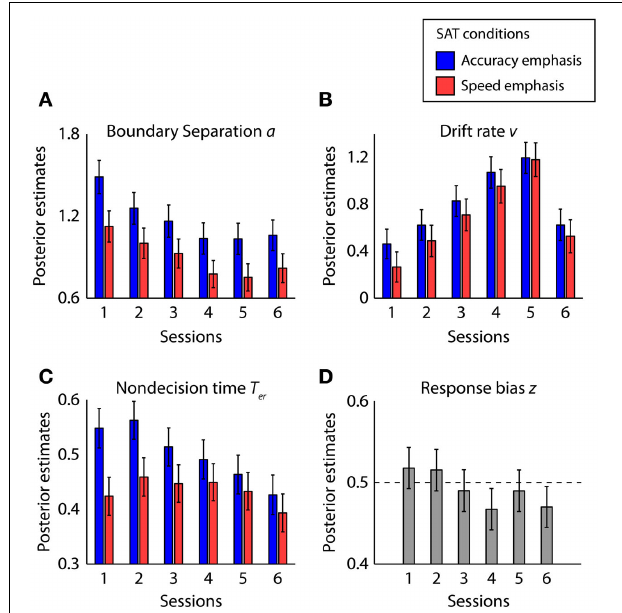
FIGURE 6 | Posterior estimates of the hierarchal drift-diffusion model parameters: (A) boundary separation a , (B) drift rate v , (C) non-decision time and T er and (D) response bias z . The bars are the sampled mean posterior estimates and the error bars are standard deviations from sampled posterior